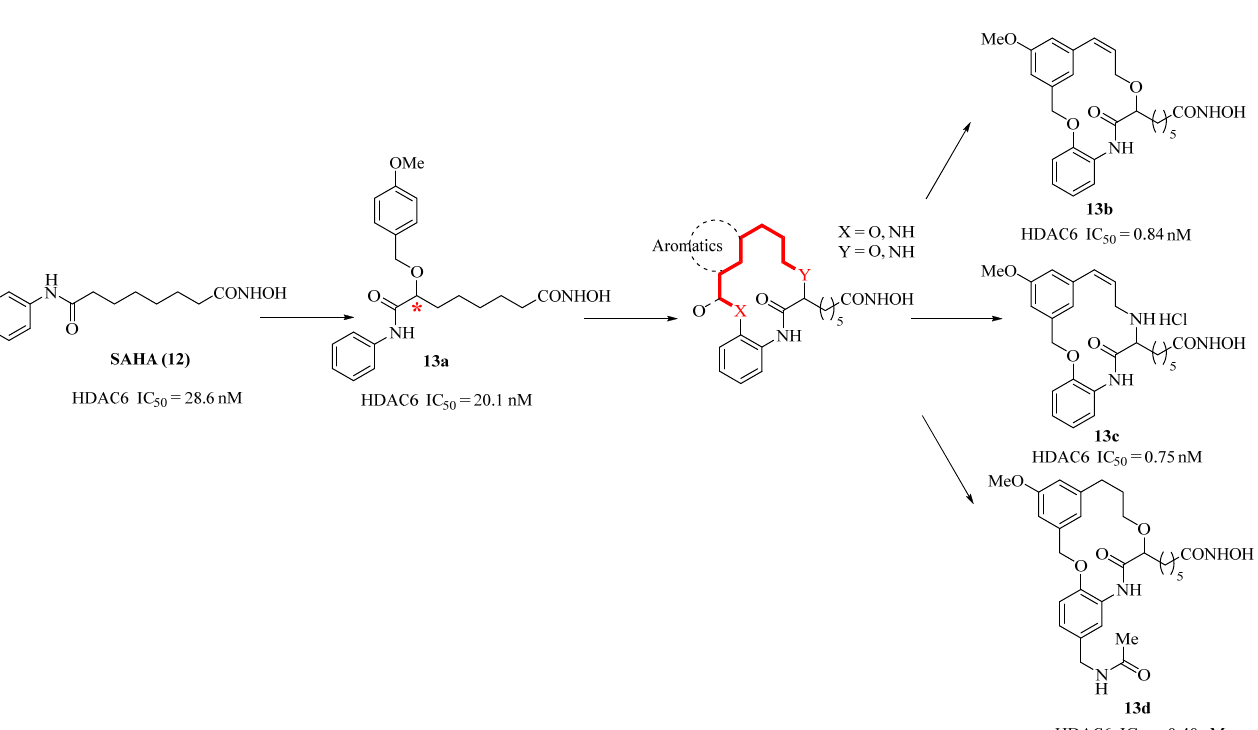
Figure 15. Structural modification of macrocyclic HDACs inhibitors.